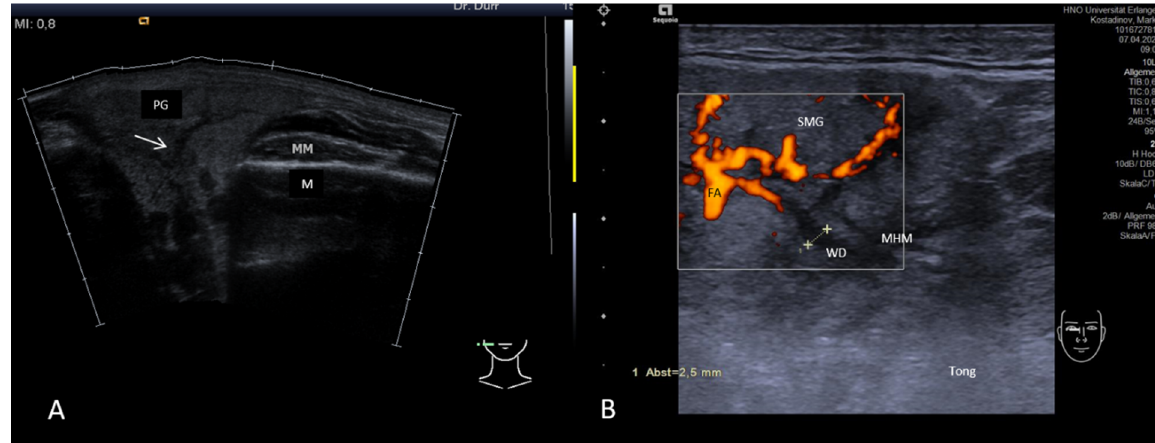
Figure 3. Acute viral sialadenitis in the PG ( A ) and in the SMG ( B ). The volume of the gland shows a tendency towards enlargement. The parenchyma is hypoechoic mainly by a spongy aspect (white arrow), which is caused by duct dilation and increased perfusion, which cannot be distinguished by plain US. Doppler-coded sonography was used to differentiate between duct dilation (Wharton’s duct dilation measuring 2.5 mm, dotted line) and vascular structures (low-flow perfusion indicated by Power Doppler, B ). Abbreviations: PG, parotid gland; SMG, submandibular gland; M, mandible; MM, masseter muscle; MHM, mylohyoid muscle; Tong, tongue; WD, Wharton’s duct; FA, facial artery.